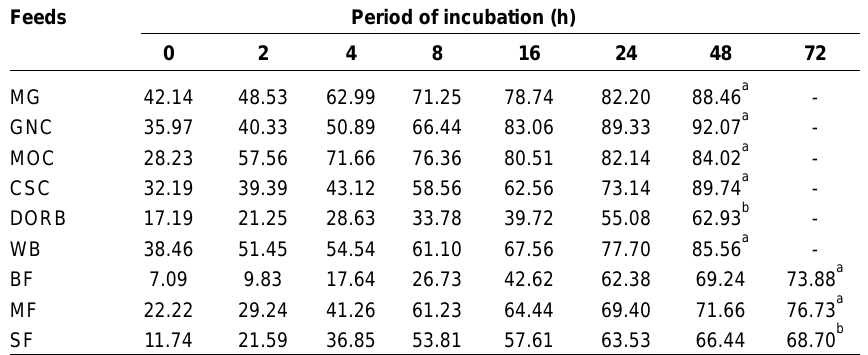
Table-4: In situ CP disappearance (%) of feedstuffs